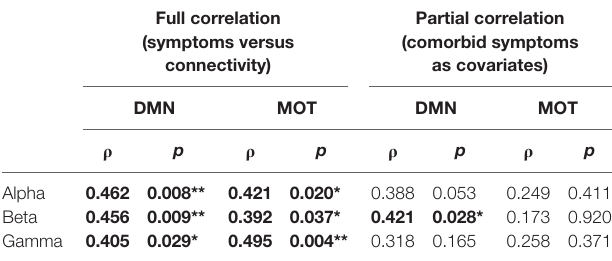
Table 2 | Correlations of band-limited connectivity in the default mode network (DMN) and motor network (MOT) against symptoms. Full correlation Partial correlation (symptoms versus (comorbid symptoms connectivity) as covariates) MOT DMn